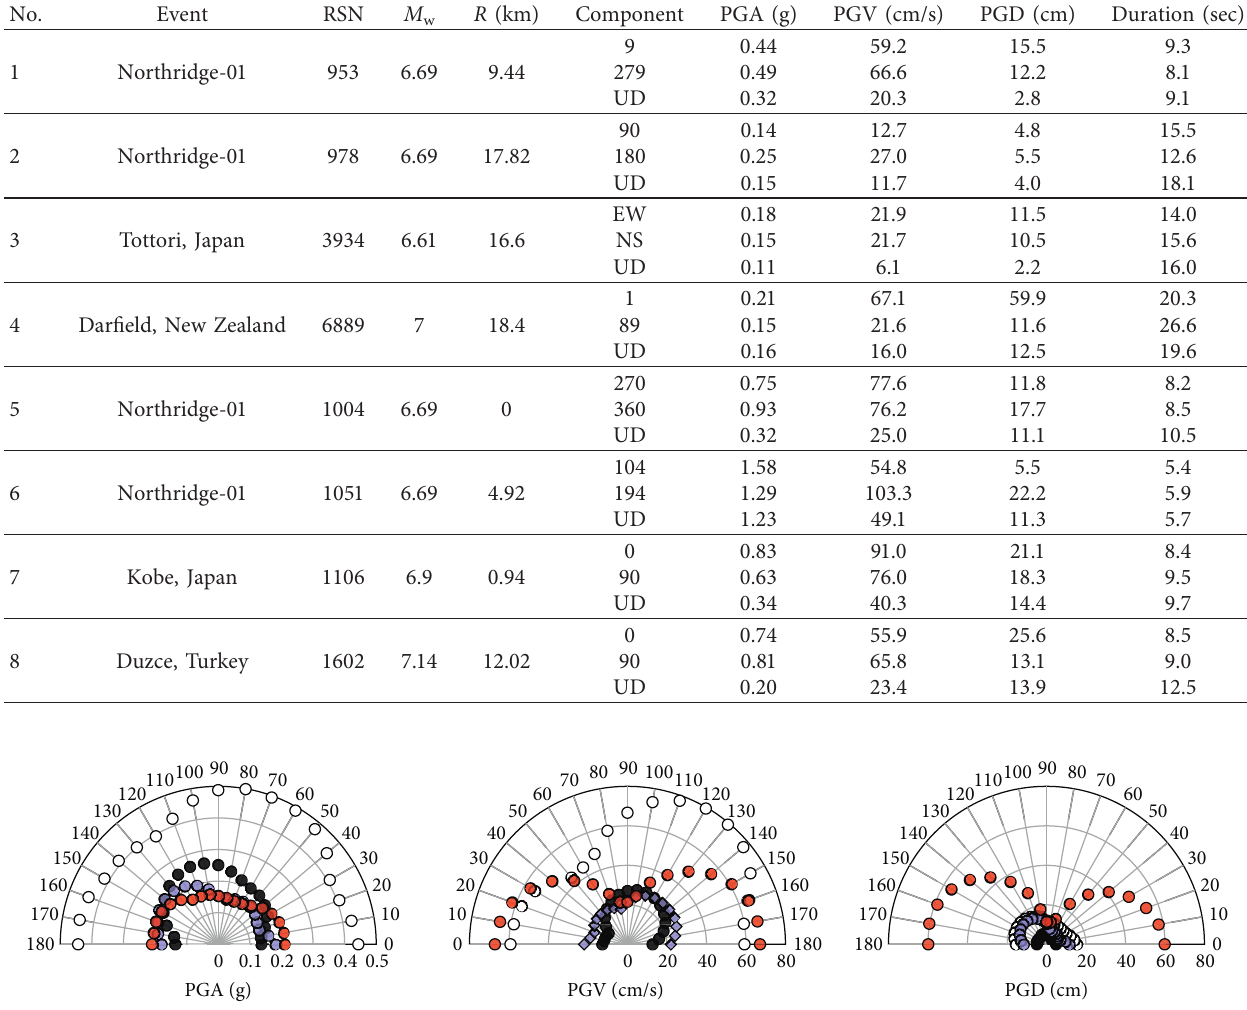
Table 1: General information of selected ground motions.